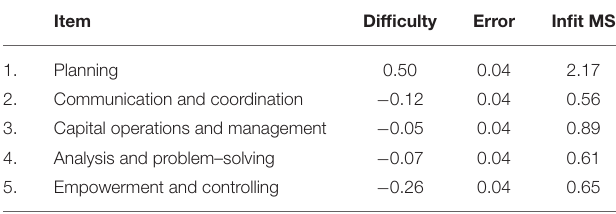
TABLE 5 | FACETS analysis of item difficulty.